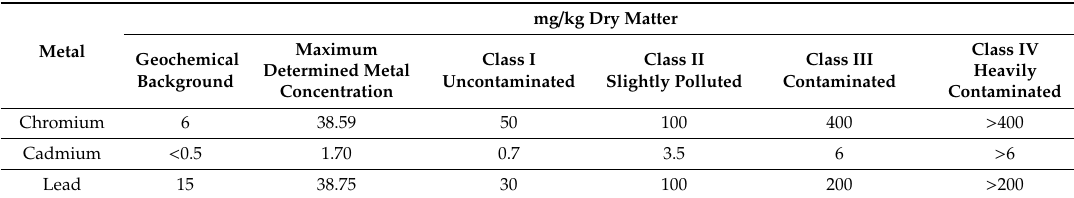
Table 4. Comparison of maximum concentrations of tested heavy metals determined in sediments from the Sulej ó w Reservoir with the values adopted in the sediment classification bottom based on geochemical criteria [33].